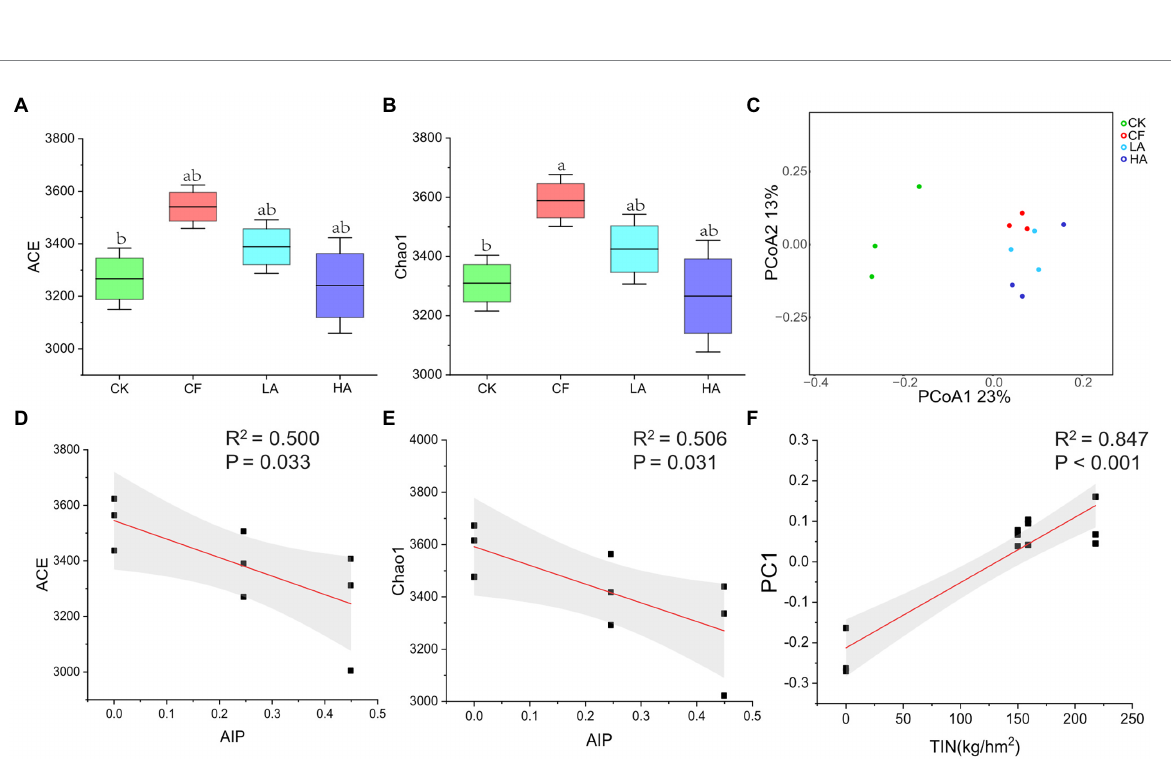
FIGURE 1 Soil bacterial community diversity and structure among different fertilization treatments. (A) Chao1 index of the bacterial community. (B) ACE index of the bacterial community. (C) ß-Diversity of the bacterial community. (D) Correlation analysis between AIP and Chao1. (E) Correlation analysis between AIP and ACE. (F) Correlation analysis between total inorganic N (kg/hm2) and ß-diversity. Different labeled letters indicate significant differences between different treatments according to one-way ANOVA with Duncan’s multiple range tests ( p < 0.05).